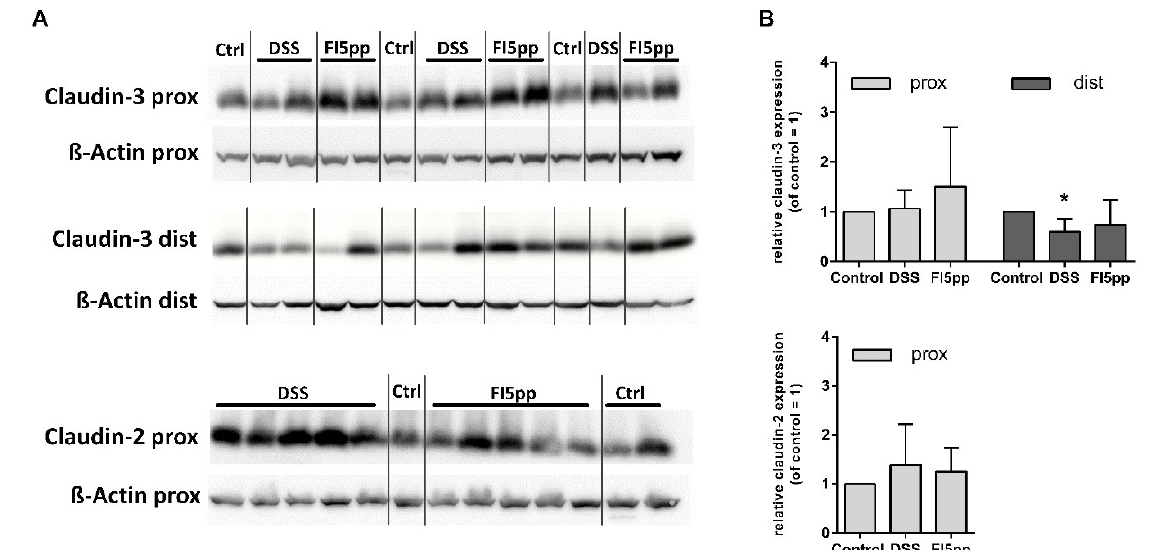
Figure 3. Representative Western blot images of claudin-2 protein (in proximal colonic tissue) and claudin-3 protein (in proximal and distal colonic tissues). Each lane represents an individual mouse ( A ). Quantification of relative expression levels of tight junction proteins claudin-2 and claudin-3 compared to control ( B ). Protein expression was quantified using densitometry analysis. Specific protein expression was normalized to β -actin expression. The results are shown as means ± SD (n = 6). *, p < 0.05, vs. control group, as determined by Mann–Whitney U test.